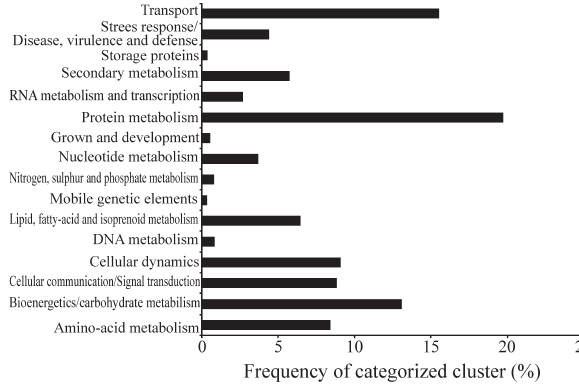
Figure 1 - Distribution of categorized clusters according to putative bio- logical function defined by MIPS. Protein matches resulting from BLASTXsearcheswereassignedtooneofsevenfunctionalcategoriesfor comparisons involving life cycle. Percentage of frequency of clusters was shown in each category from a total set of categorized PP clusters.